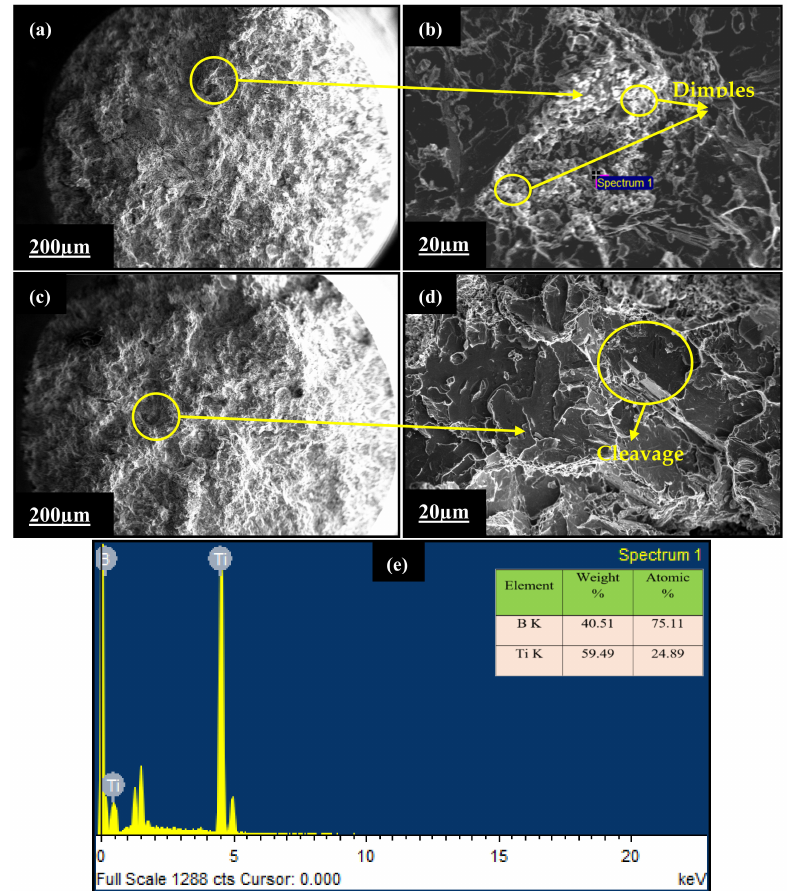
Figure 17. Fracture analysis of the ( a , b ) as-cast and ( c , d ) peak-aged LM4 + 3 wt.% TiB 2 tensile sample. ( e ) EDAX report of the